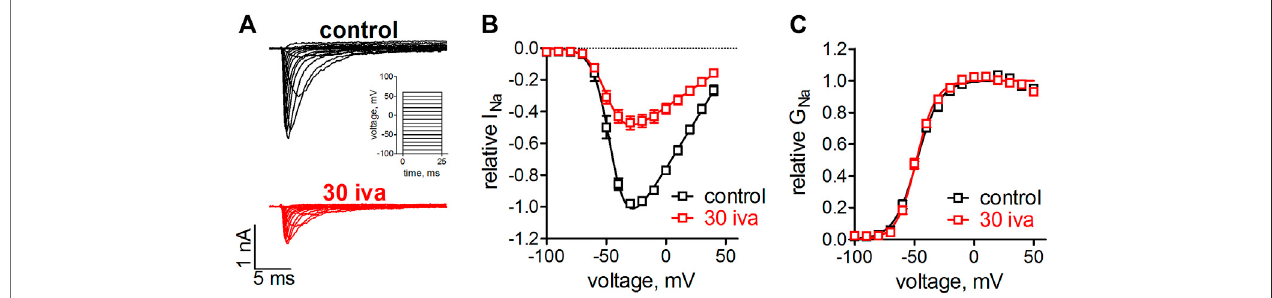
FIGURE1| Effectofivabradineonthevoltage-dependenceonactivationinhumanNa v 1.5channels.tsA-201cellsexpressinghumanNa v 1.5channelswereheldat aholdingpotentialof − 100 mVandsodiumcurrentswereelicitedby25 ms,rectangularstepstovariousvoltages(in10 mVincrement,seeinsetin A ). (A) Originalcurrent tracesaselicited by thevoltage-clamp protocol in theabsence(top, black) and presence of 30 µM ivabradine (bottom, red). (B) Current-voltage relationships asderived from the maximal inward current at the applied voltages. (C) Conductance-voltage relationships as derived from B . No signi fi cant differences were found between the half point of voltage-dependent activation, V 1/2 = − 48 ± 1 mV and − 48 ± 1 mV ( p = 0.7), and the steepness of activation, k = 9.7 ± 0.9 and 8.1 ± 0.6 ( p = 0.15), for control ( n = 5) and in the presence of ivabradine ( n = 9), respectively.